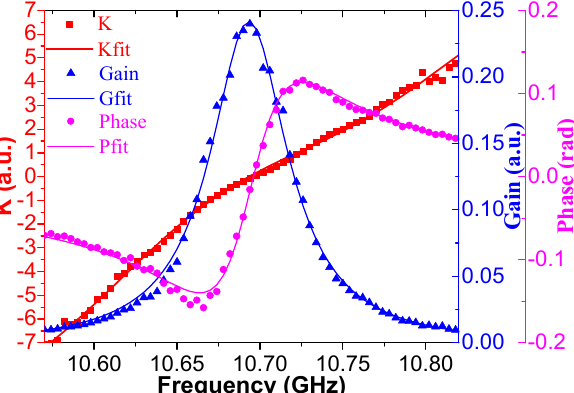
Figure 11. The experimental results for a 20-ns pump pulse [11]. BGS: blue line and dot. BPSS: magenta line and dot. KS: red line and dot. The dots are the experimental data and the lines are their fitting curves.